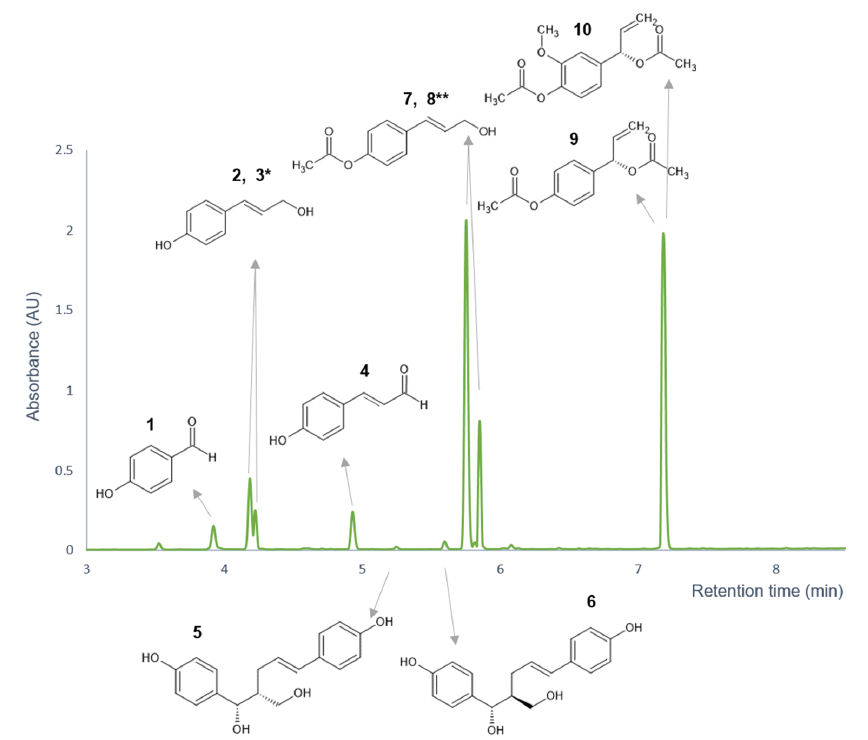
Figure 3. The structures of the isolated compounds in the chromatogram of the ethyl acetate extract stock solution, which were elucidated by Orbitrap ® mass spectrometry hyphenated to UHPLC separation and by NMR spectroscopy. * Compound 3 was identified as an isomer of compound 2 . ** Compound 8 was identified as an isomer of compound 7 .